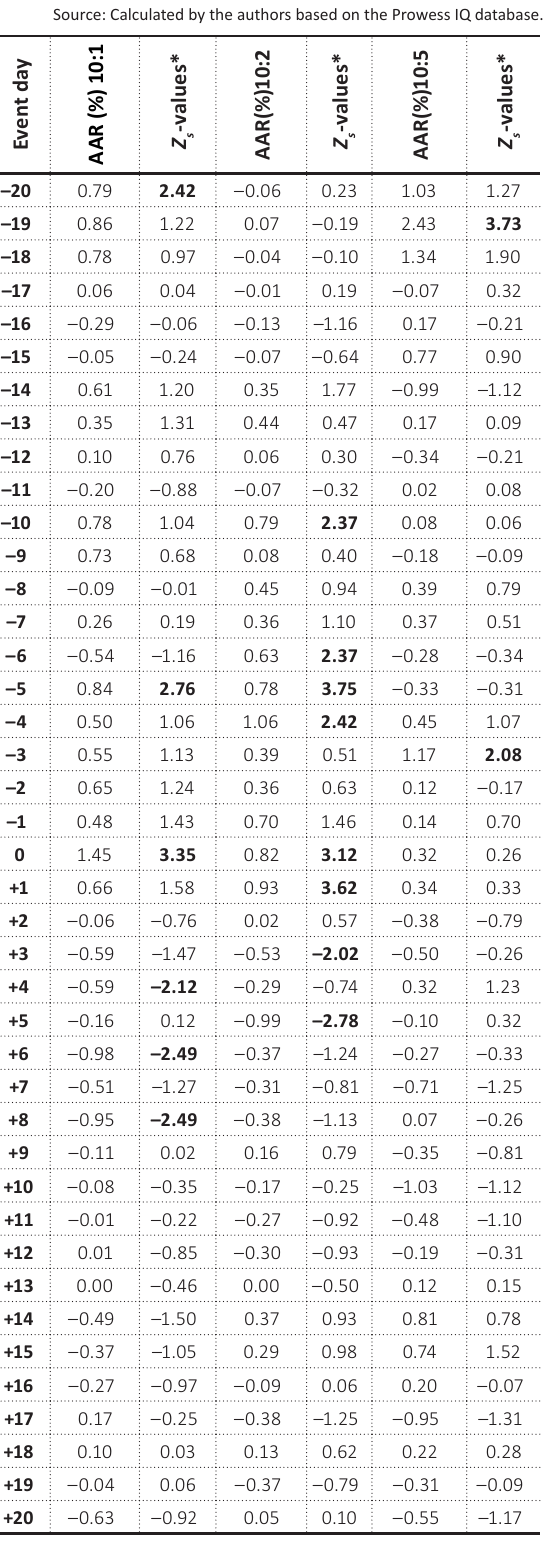
Table 6. AARs and Z Day (different stock split